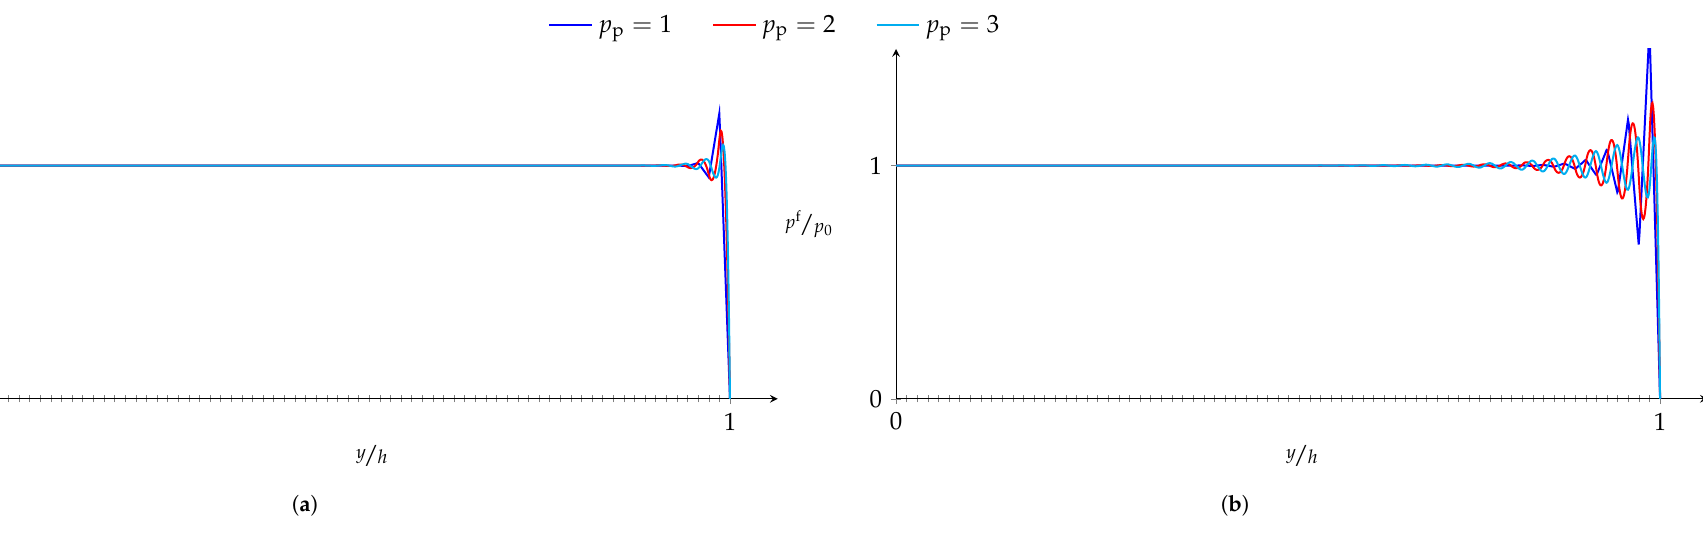
Figure 5. Numerical solution to the Terzaghi problem with N e = 72 using a sub-critical time step of ∆ t = 0.1 ∆ t c for different polynomial degrees. All plots are shown for the first time step. ( a ) Mixed. ( b ) Equal